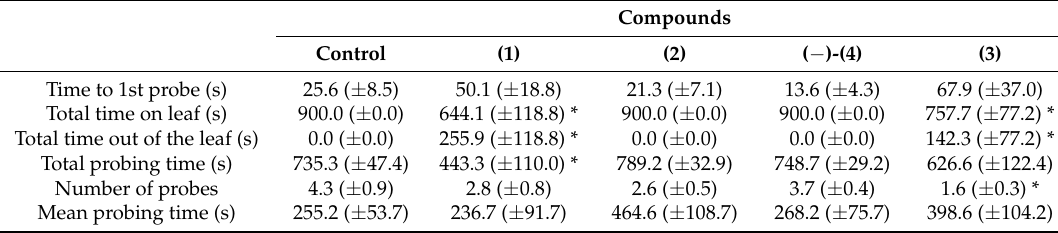
Values represent means ± SE (= Standard Error). Time given in seconds, * asterisks indicate statistically significant differences in relation to control at p ≤